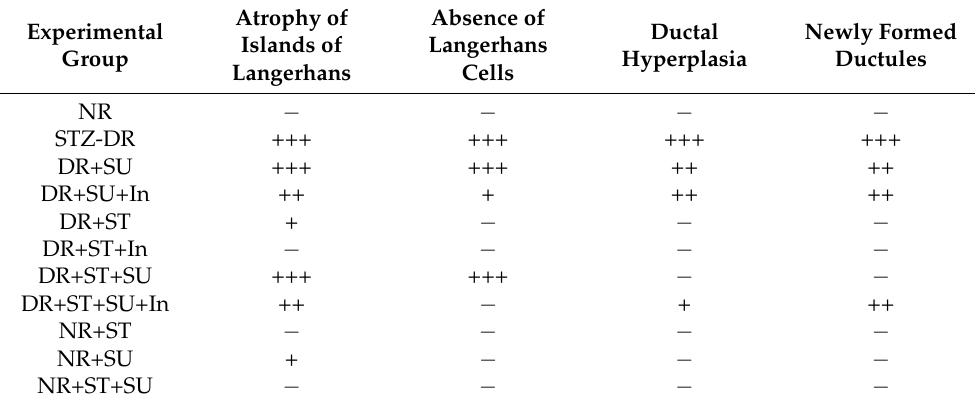
Absence of Ductal Newly Formed Langerhans Hyperplasia Cells